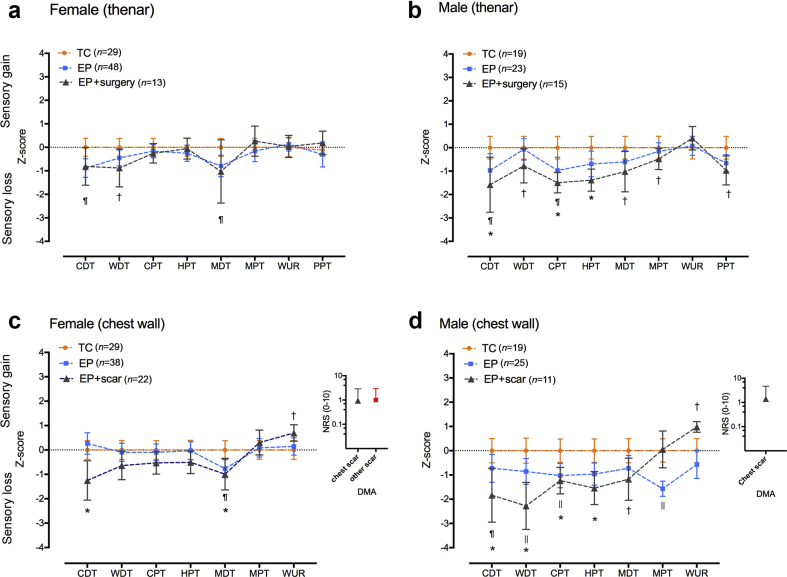
Somatosensory profiles on hand and chest. (a,b) Thenar sensory profiles in extremely preterm (EP) females (a) show minor differences in z-score (normalised to term controls, TC). (b) In EP males with neonatal surgery (EP+surg), differences from TC extend across thermal and mechanical modalities. (c,d) Adjacent to neonatal thoracic scars (EP+scar), minor differences in warm and mechanical detection are seen in females (c) but in EP males there are generalised reductions in threshold sensitivity on the chest wall that are more marked in the EP+scar group (d). Scar-related perceptual sensitisation (positive wind-up ratio) and dynamic mechanical allodynia (DMA; numerical rating scale, NRS 0–10) to brush is observed in females (neonatal scars on chest wall or other body sites) and males. Data = z-score mean (95%CI) with increased sensitivity represented as positive and decreased sensitivity as negative values. EP vs TC: ¶P<0.05 ||P<0.01; EP+surgery or EP+scar vs TC: †P<0.05 *P<0.01.